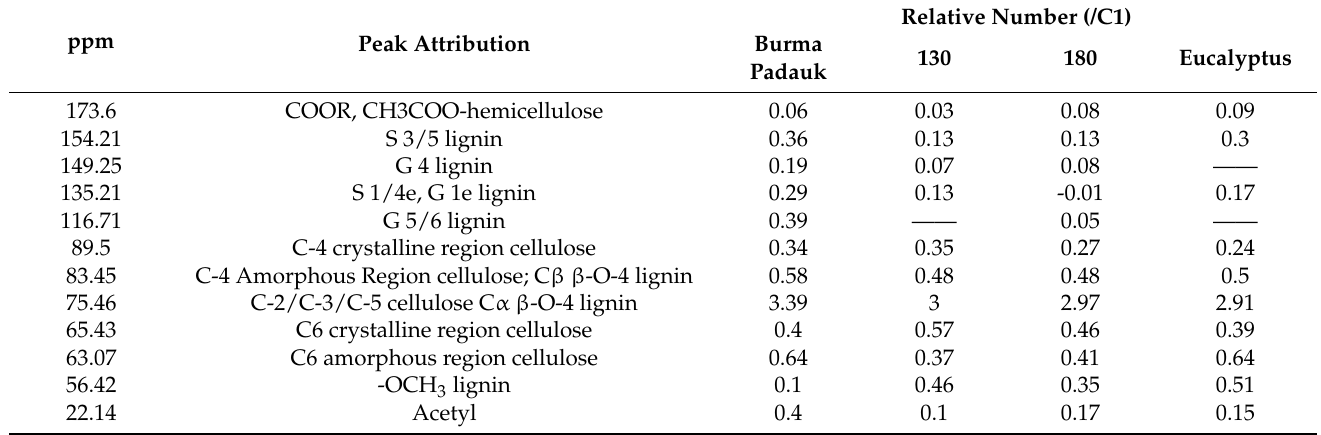
Table 3. NMR data of Eucalyptus and Burma padauk